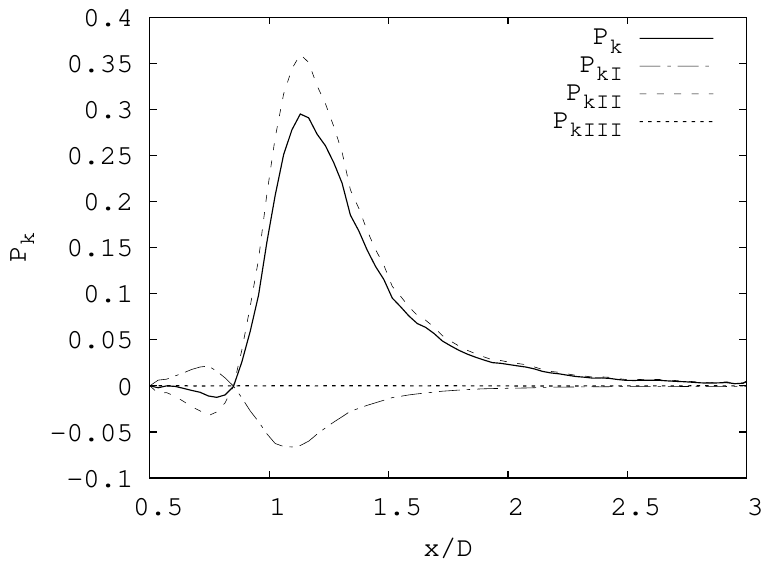
Figure 10. Production of turbulent kinetic energy in the wake centerline and the contribution of the different terms in Equations in Section 3.1.